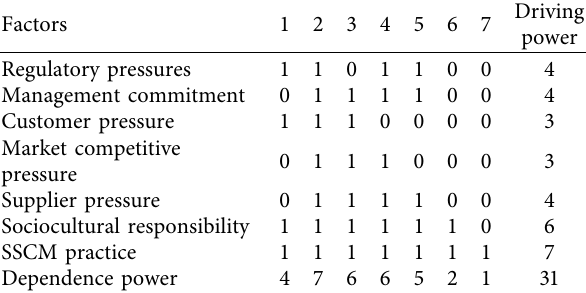
Figure 1: ISM model. Table 2: Te fnal reachability